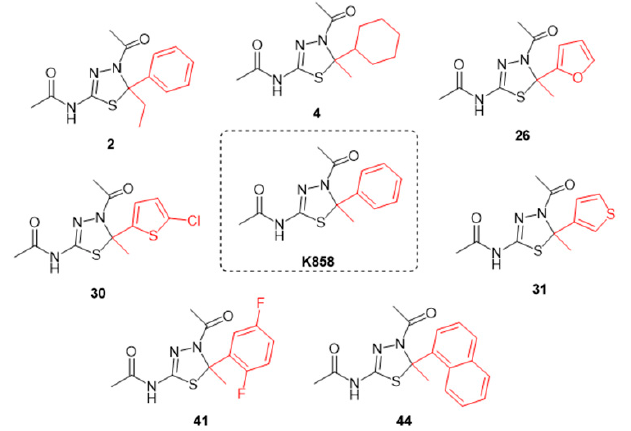
Figure 1. Molecular structures of seven thiadiazoline Eg5 inhibitors and their parent compound K858. In red, different substitutions on the